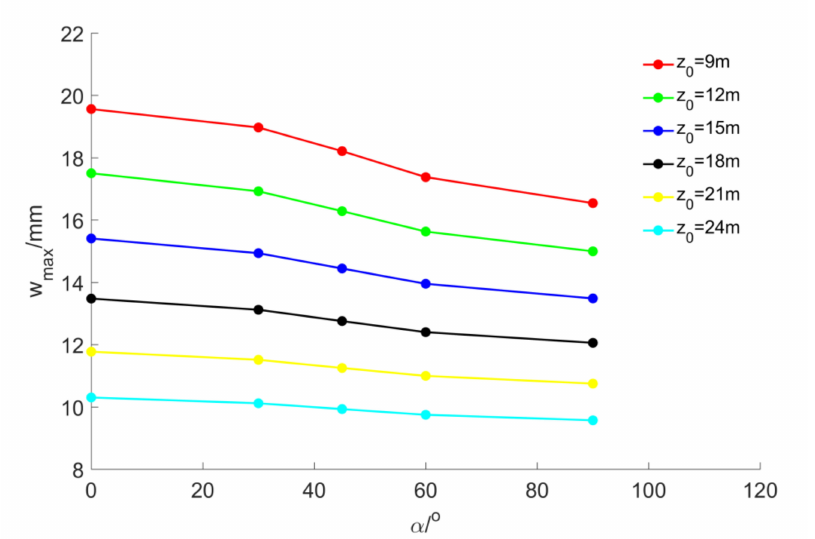
Figure 15. Influence of tunnel–surcharge angle on the maximum longitudinal displacement of the existing